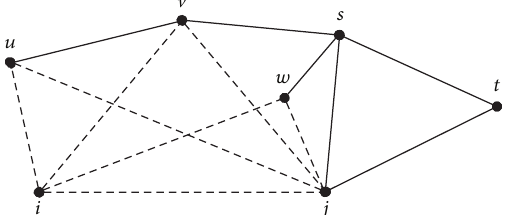
Figure 1: The dashed line represents the triangles with a shared edge | △ | = 3 𝑒 𝑖𝑗 and (𝑖,𝑗)